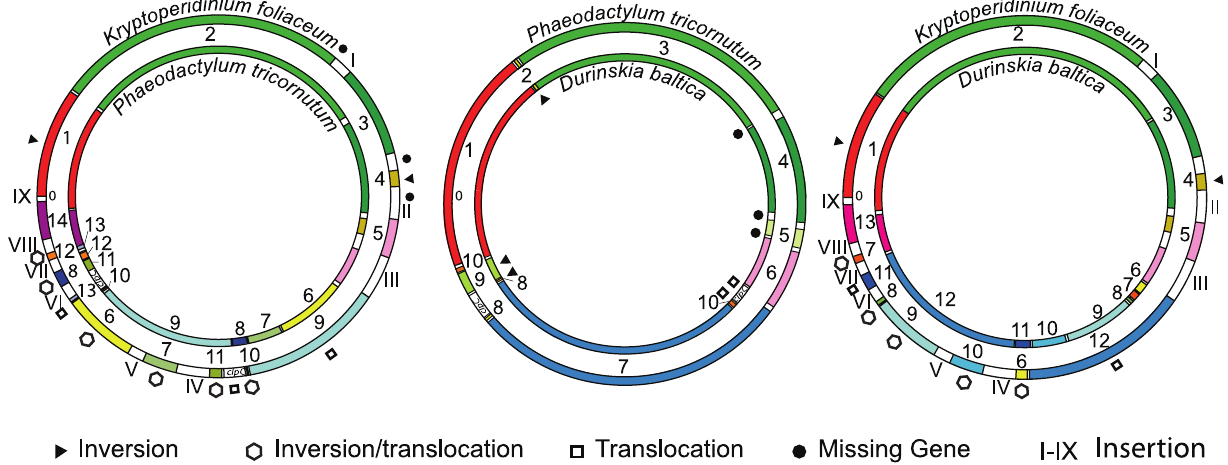
Figure 2. Conserved ordered gene blocks among three plastid genomes. All possible two-way comparisons between plastid genomes of K. foliaceum, D. baltica , and P. tricornutum . Conserved blocks of genes are indicated by color, inversions are marked by a black triangle, inversions/ translocations by a hexagon, translocations by a rectangle, missing genes by a black circle and insertions by Roman numerals I-IX.